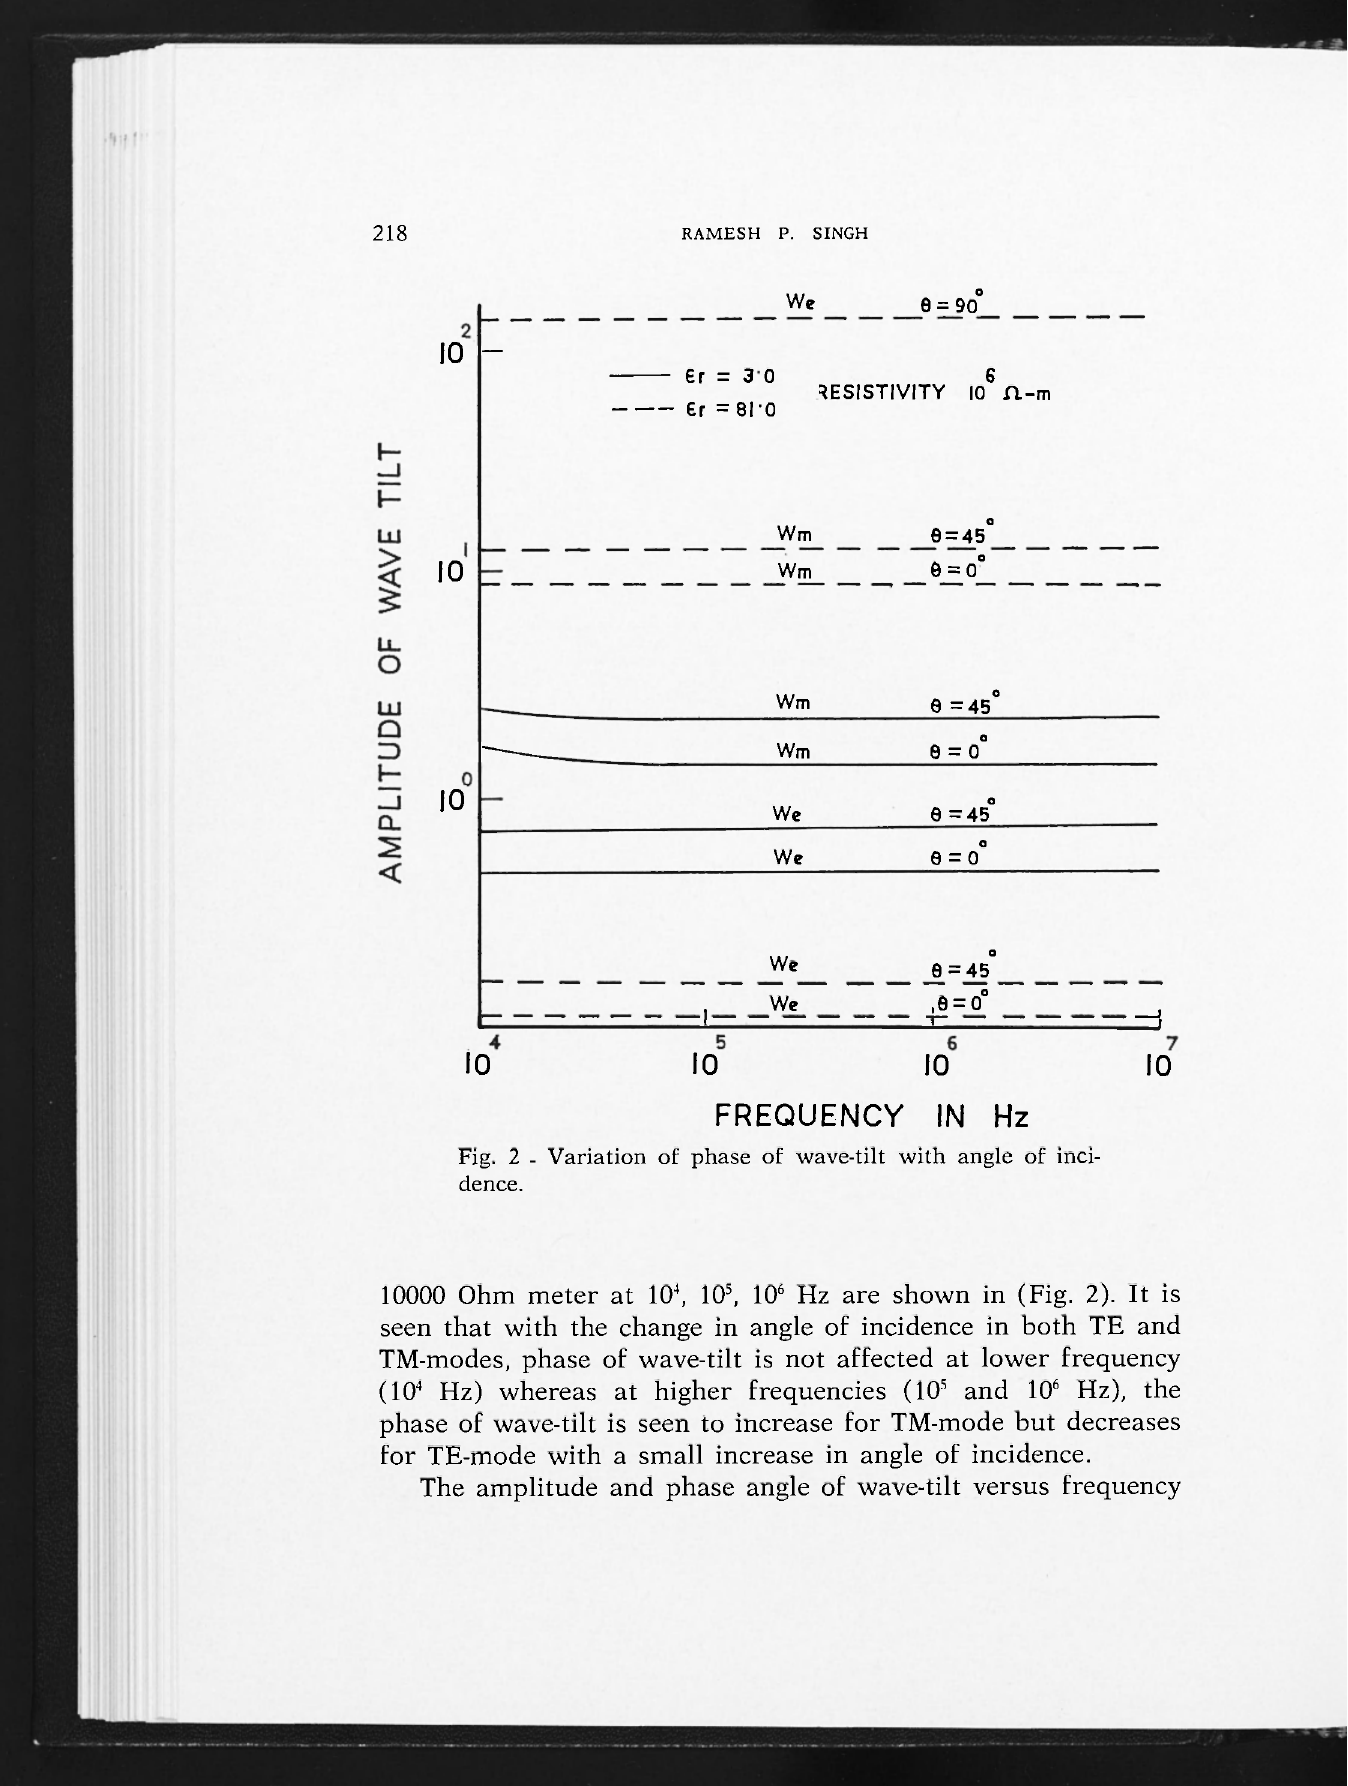
10000 Ohm meter at 10 4 , 10 5 , 10" Hz are shown in (Fig. 2). It is seen that with the change in angle of incidence in both TE and TM-modes, phase of wave-tilt is not affected at lower frequency (10 4 Hz) whereas at higher frequencies (10 s and 10 6 Hz), the phase of wave-tilt is seen to increase for TM-mode but decreases for TE-mode with a small increase in angle of incidence. The amplitude and phase angle of wave-tilt versus